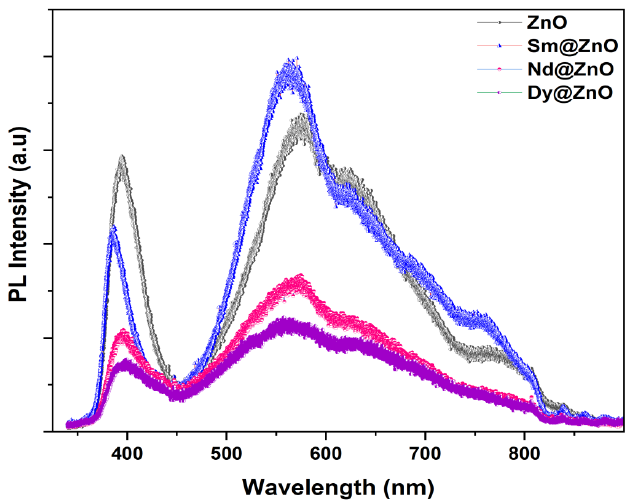
Figure 8. Room temperature PL spectra for all synthesized samples.